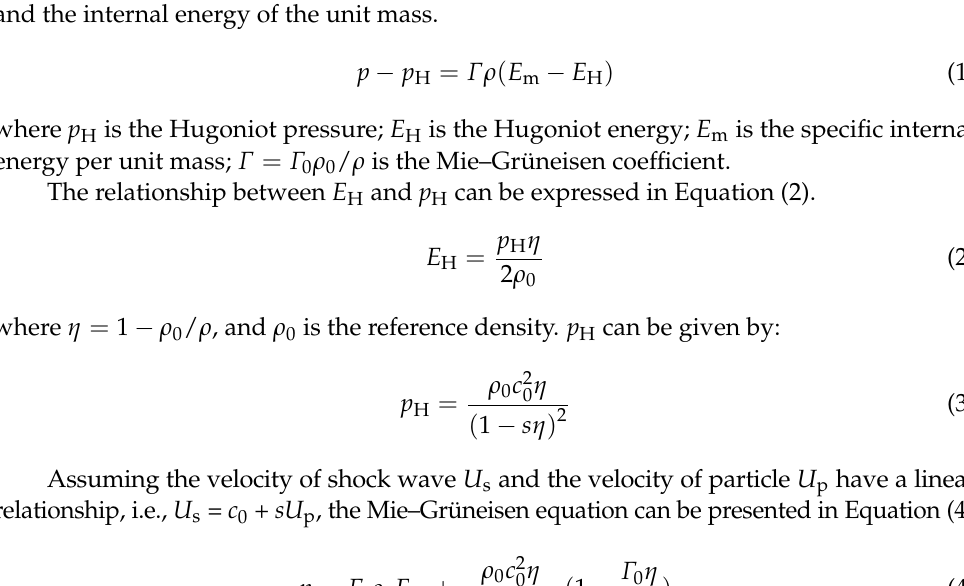
Figure 12. Mesh sensitivity analyses with various mesh sizes for the Eulerian domain.